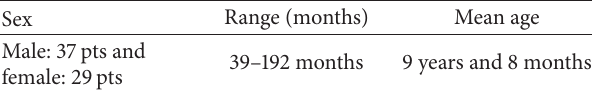
Table 1: Demographic characteristics of